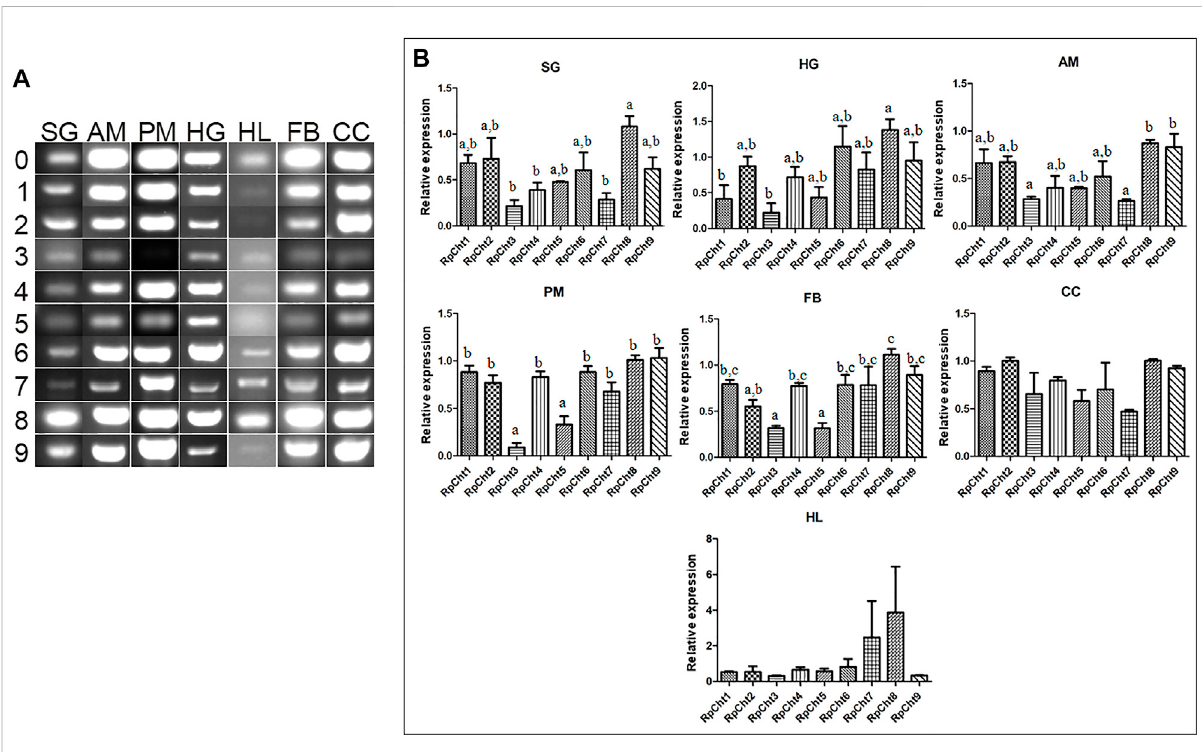
FIGURE 5 Expression pro fi lingofchitinasegenesindifferenttissues of R.prolixus fi fth-instarnymphs asevaluated byRT-PCR. (A) Columnscorrespondto differenttissues;SG,salivaryglands;AM,anteriormidgut;PM,posteriormidgut;HG,hindgut;HL,hemolymph;FB,fatbody;CC,carcass.Lane0isthe constitutive reference gene (actin), and 1 – 9 represent genes RpCht1-9 , respectively. (B) Relative expression using Actin as constitutive reference gene,obtainedwiththeImageJprogram(bybanddensitometry).Valuesmarkedwitha,bandccorrespondtosigni fi cantlydifferentgroups( p < 0.05; one-way ANOVA – Tukey). The experiment was performed three times with independent biological